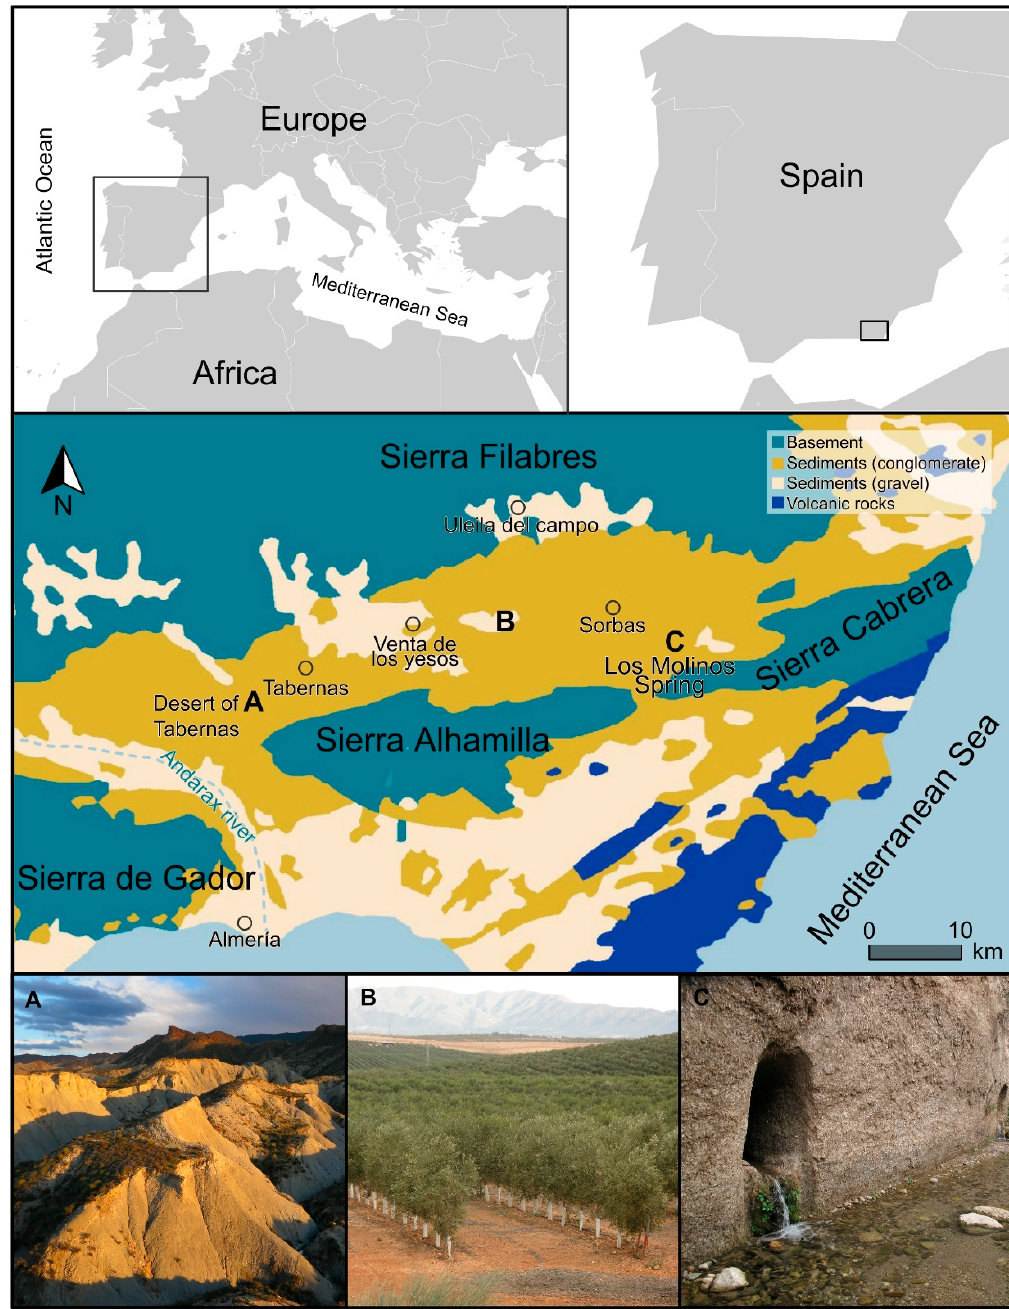
Figure 1. Location map of the Tabernas-Sorbas depression. ( A ) Typical landscape of the Desert of Tabernas. ( B ) Irrigated olive groves and ( C ) galleries made for the collection of water from the aquifer in Los Molinos spring. (( A ) picture source: J. Martínez-Valderrama; ( B , C ) pictures source: Club Almeriense de Montañismo).